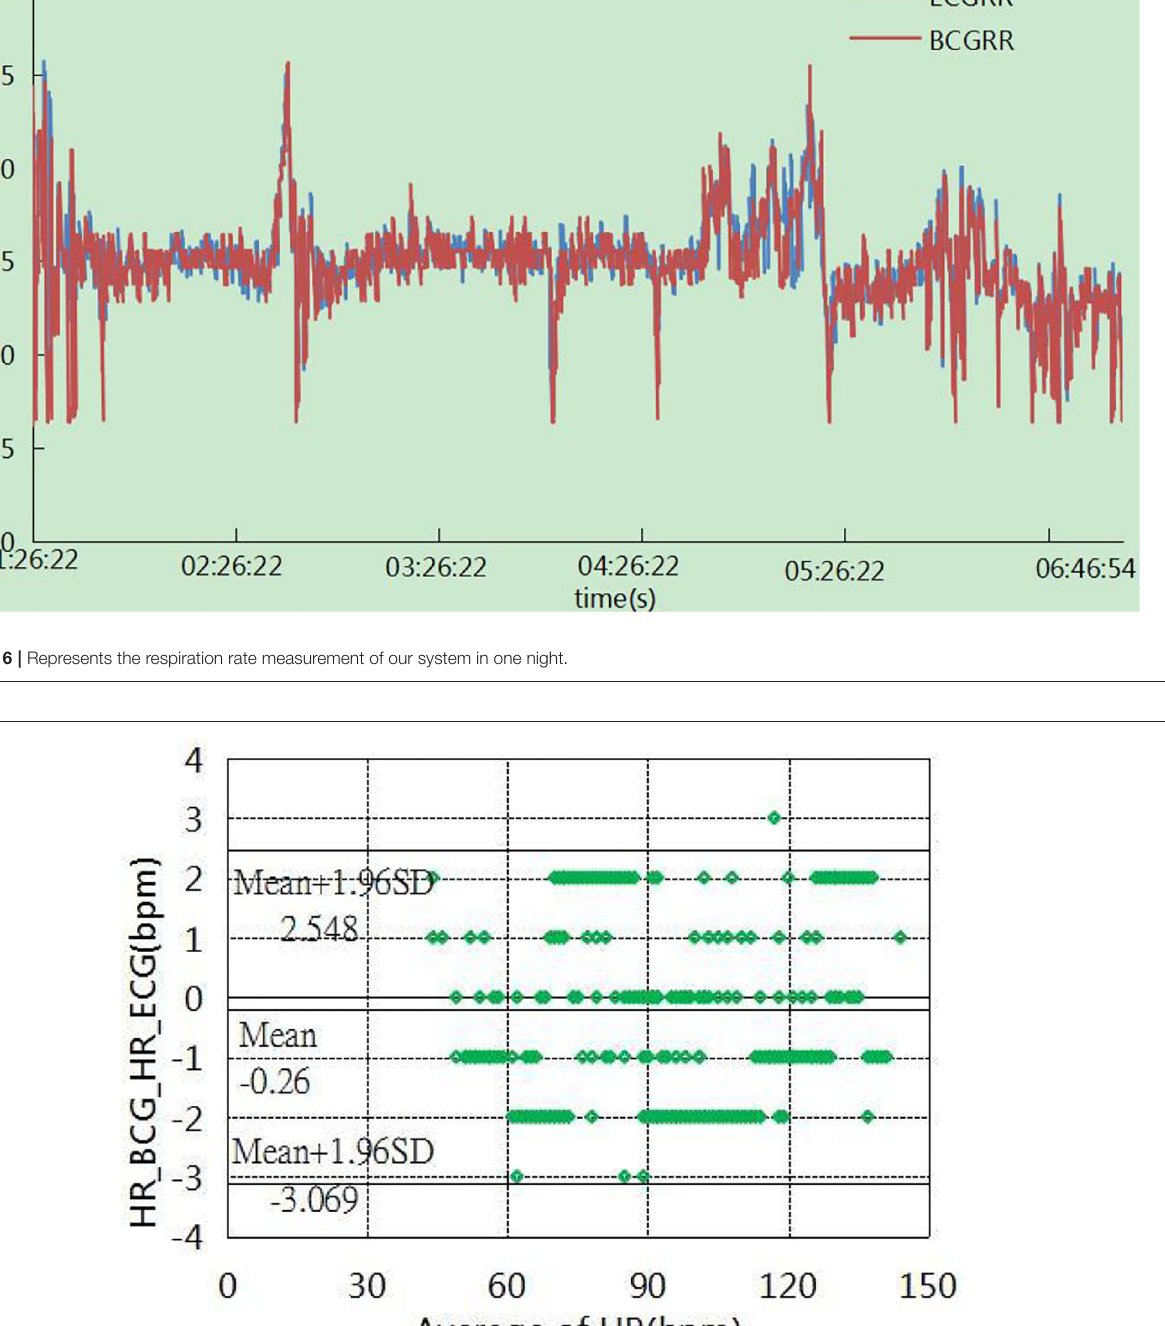
and evaluated using the Bland-Altman plot ( Figure 17 ). The results showed that the mean error in the range of a 40 to 145 heart rate within ( ± 1.96 SD) was − 0.26 ± 2.80 bpm, tests of